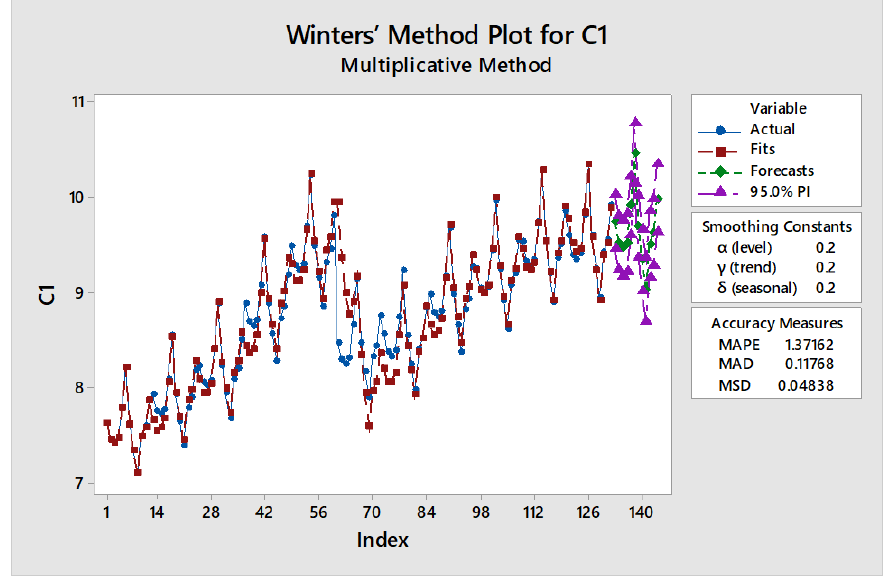
Fig. 8. Forecast result using winters method output from Minitab 18 software